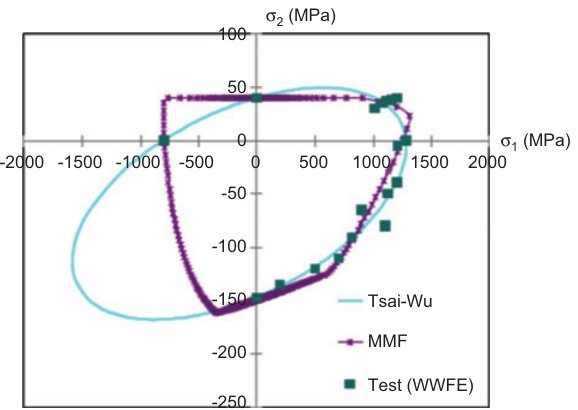
Figure 10 MMF and Tsai-Wu failure envelopes plotted for unidi- rectional E-glass/MY750 ply in σ test data (adapted from Ha et al. [2]